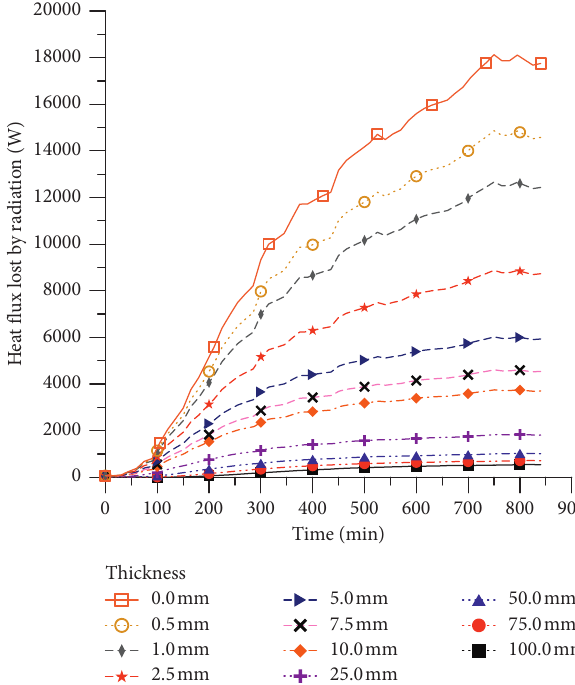
Figure 11: Heat flux lost by radiation during the heating process for different ceramic fiber thicknesses.